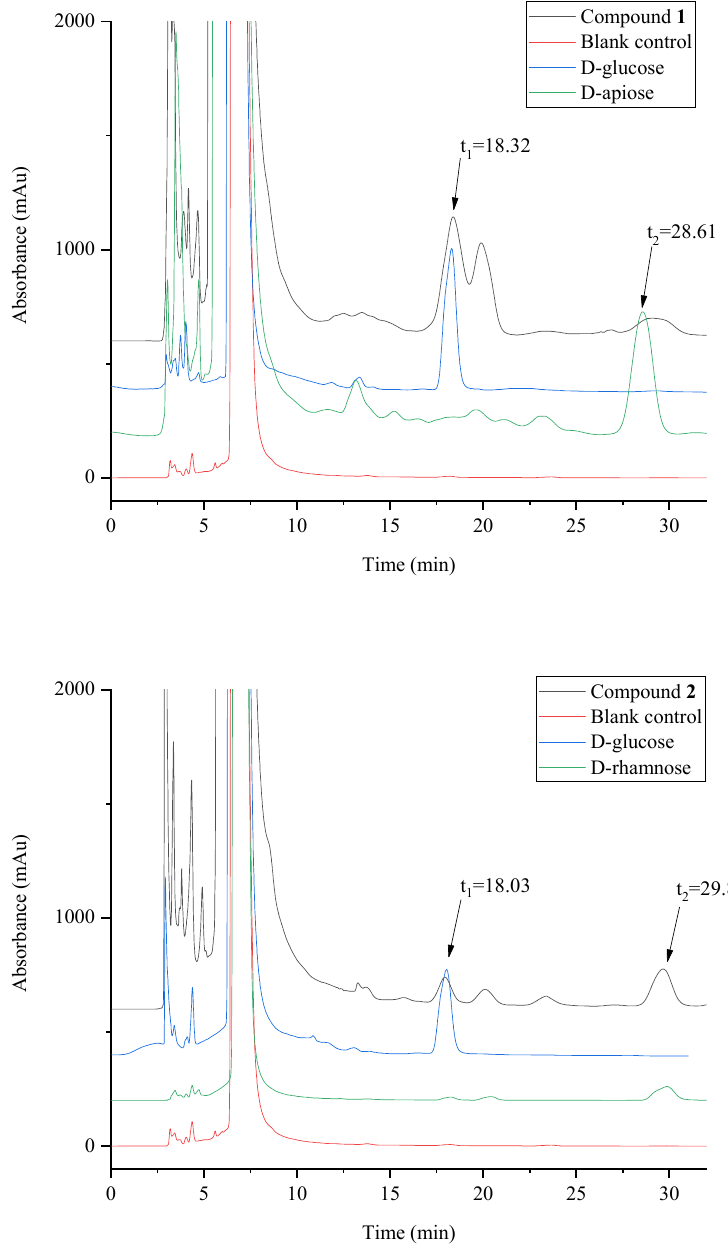
Figure 6. HPLC chromatogram for the determination of sugar configuration. Analytical column: Shimadzu Shim-pack GIST C 18 (250 × 4.6 mm, 5 µ m, Shimadzu, Japan); mobile phase: 25% CH 3 CN in water; flow rate: 0.8 mL/min; detection: 254 nm.